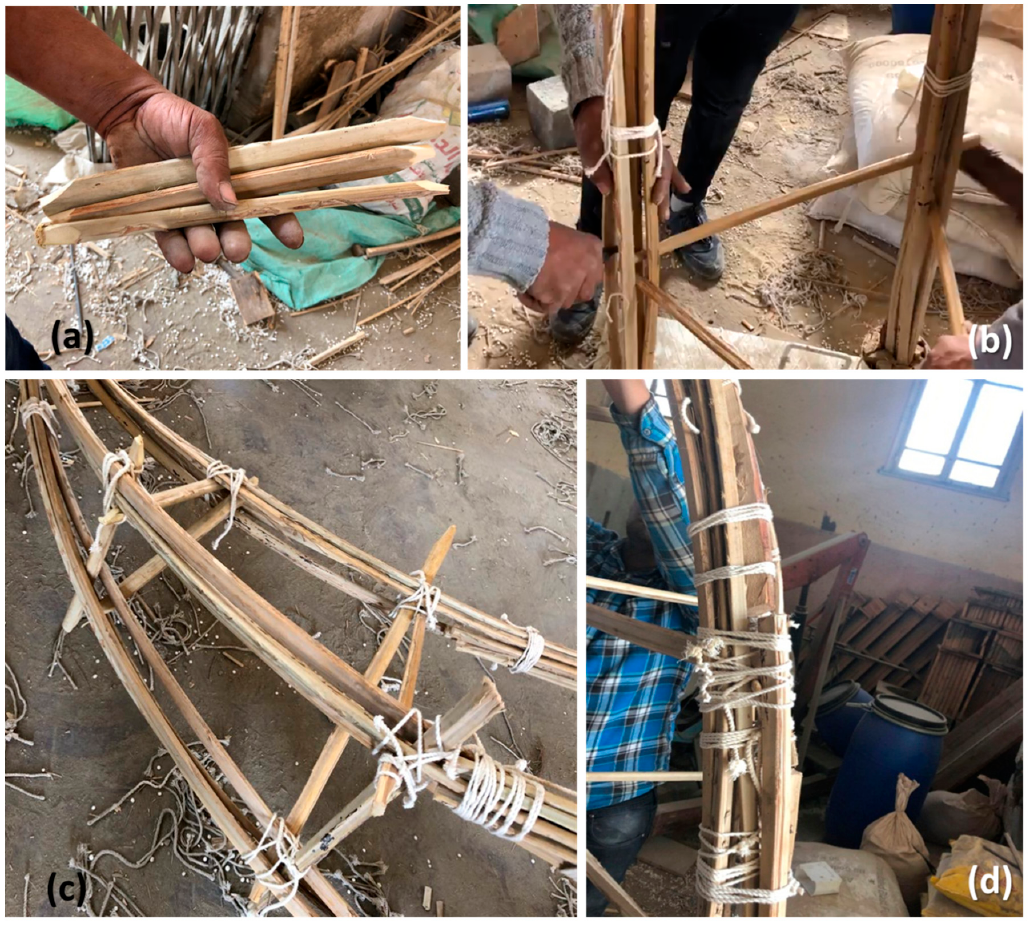
Figure 13. Installing the bracings. ( a ) The sharpened ends of the bracings. ( b ) A worker is opening a space between the midribs in a bundle using a chisel where the second worker is driving the bracing midrib by a wooden hammer. ( c ) Fastening the bundles with ropes before and after the bracing insertion. ( d ) The detail of the overlap after fixing additional midribs to increase the cross-section of the bottom bundles. Buildings 2020 , 10 , x FOR PEER REVIEW